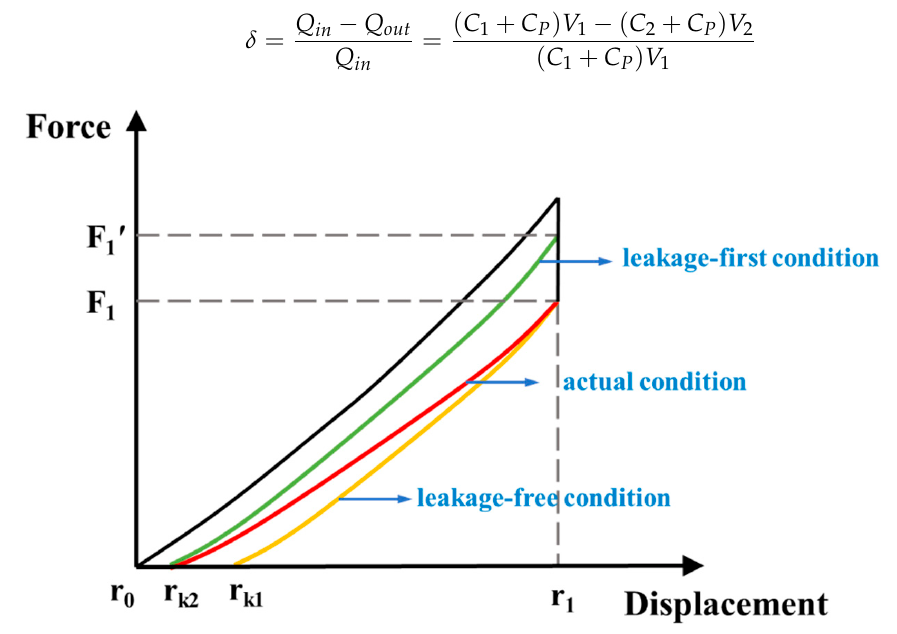
Figure 6. Force-displacement curve of the DEG under different charge leakage conditions.